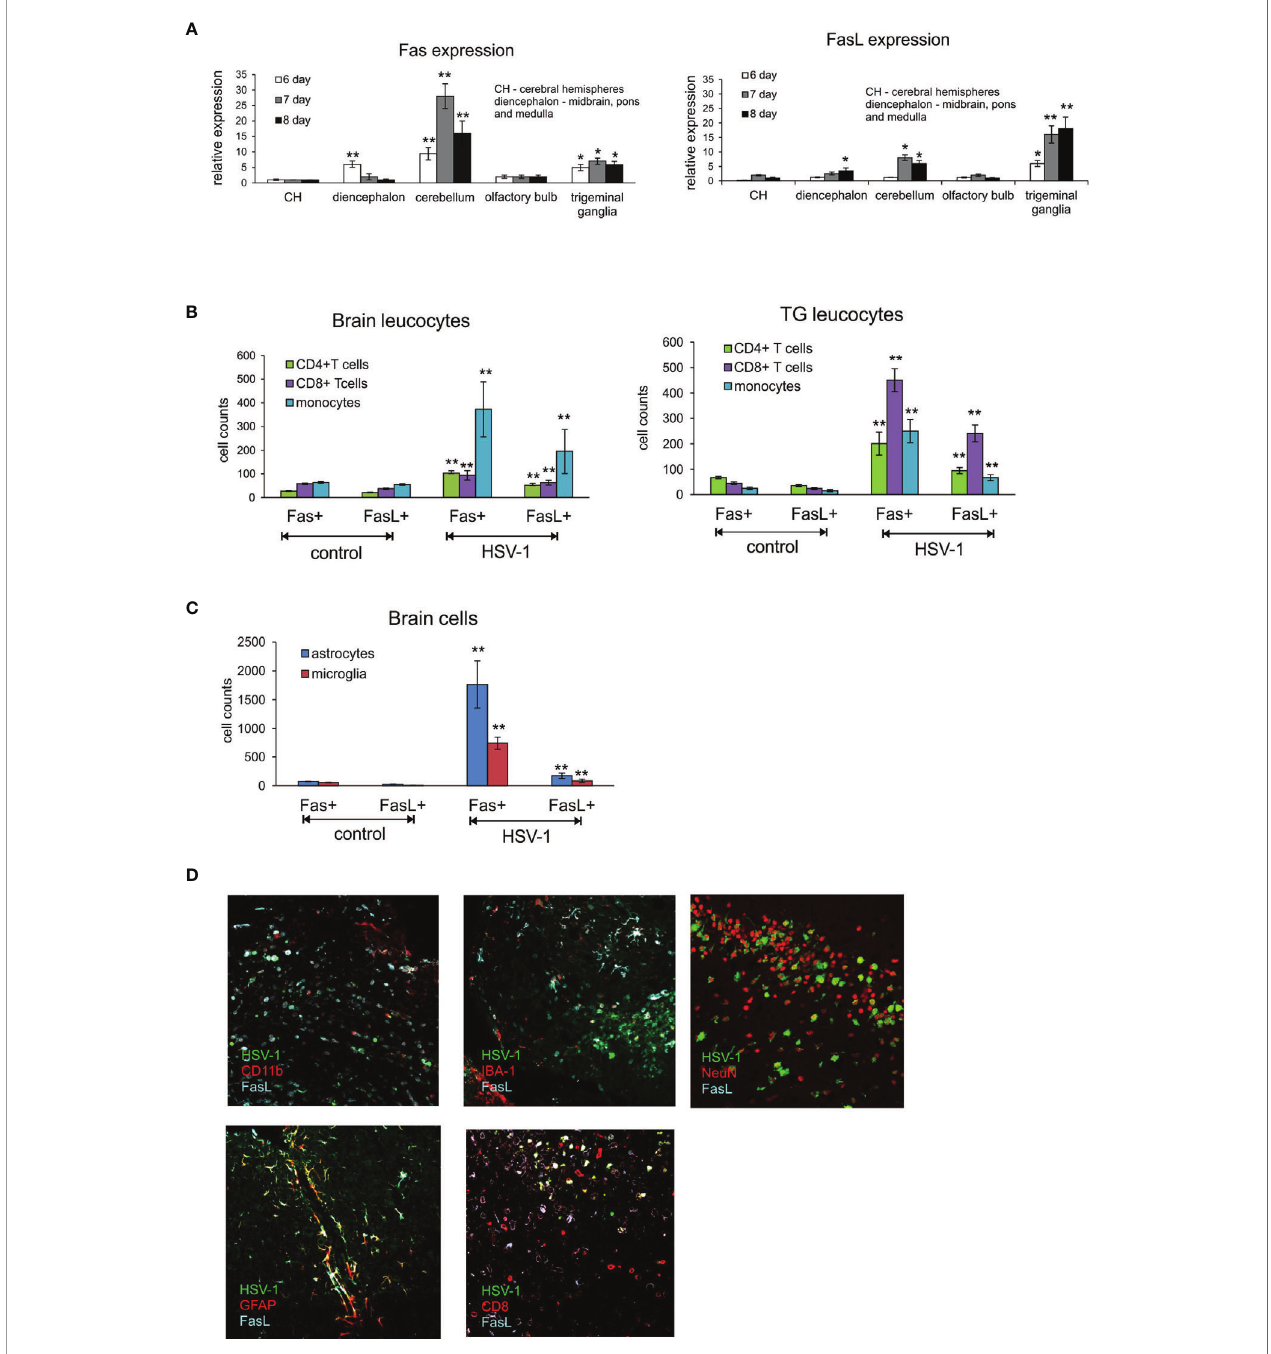
FIGURE 1 | Fas/FasL expression correlates with HSV-1 infection in C57BL/6 mice. (A) Fas (left) and FasL (right) mRNA expressions in different brain parts: CH – cerebral hemispheres, diencephalon (midbrain, brainstem and medulla), cerebellum, olfactory bulb and trigeminal ganglia at 6-8 d p.i. were measured by quantitative real-time PCR. N = 10 animals at each time point. Data were presented as mean ± SEM. Data analysis was performed by comparing fold expression to uninfected control. **p ≤ 0.001, *p ≤ 0.05. (B) Leucocytes in brain (left) and trigeminal ganglia (right) homogenates expressing Fas or FasL were determined by fl ow cytometry at 8 d p.i. Data were presented as mean ± SEM. N = 7-9 animals. **Indicates p ≤ 0.001, *p ≤ 0.05 compared to uninfected controls. (C) Expression of Fas and FasL on resident brain cells – microglia and astrocytes – at 8 d p.i. Data were presented as mean ± SEM. N = 7-9 animals. **Indicates p ≤ 0.001, *p ≤ 0.05 compared to uninfected controls. (D) FasL expression on different cells in HSV-1 infected brains at 8 d p.i. Co-immuno fl uorescent staining for HSV-1 antigens (green), GFAP+ astrocytes (red), IBA-1 positive microglia (red), CD11b-positive monocytes (red), CD8+ T cells (red), neurons (NeuN, red) and FasL (turquoise). Midbrain (top left, middle and right, bottom right) and cortex (bottom left). Magni fi cation x